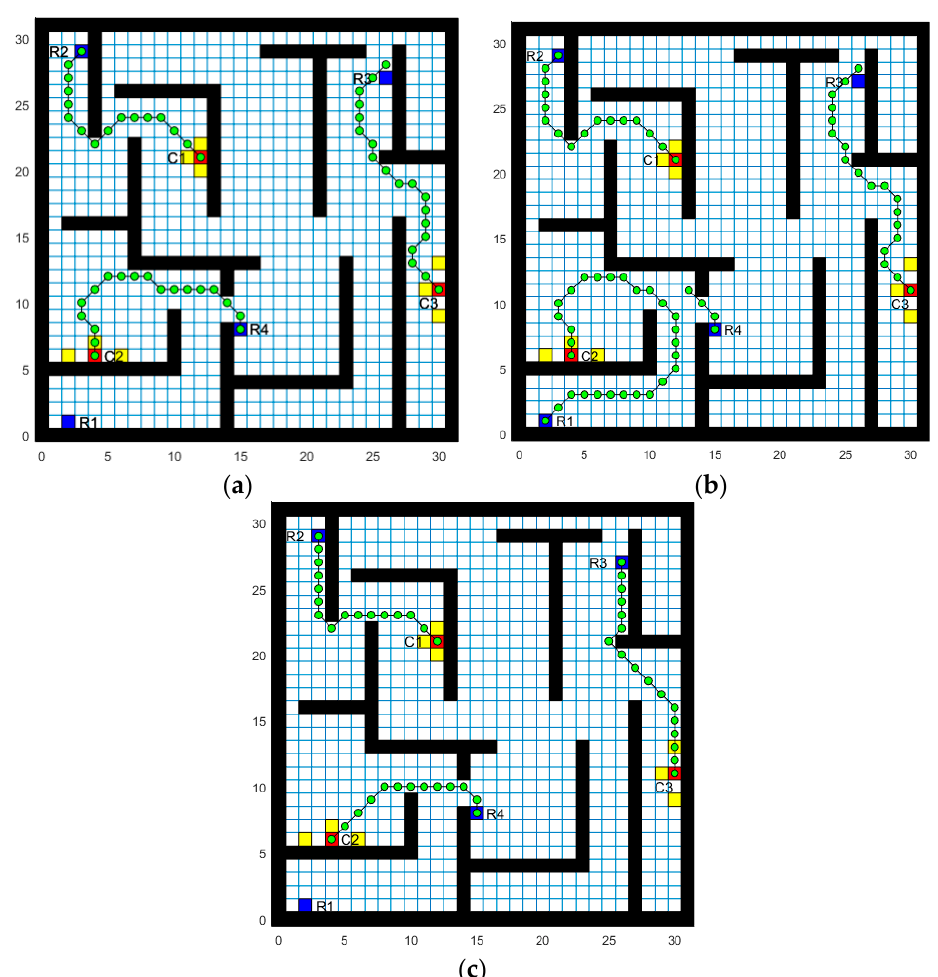
Figure 5. ( a ) Based on the BINN task assignment and path planning algorithm; ( b ) Based on the BISOM task assignment and path planning algorithm; ( c ) Based on the AE task assignment and path planning algorithm.